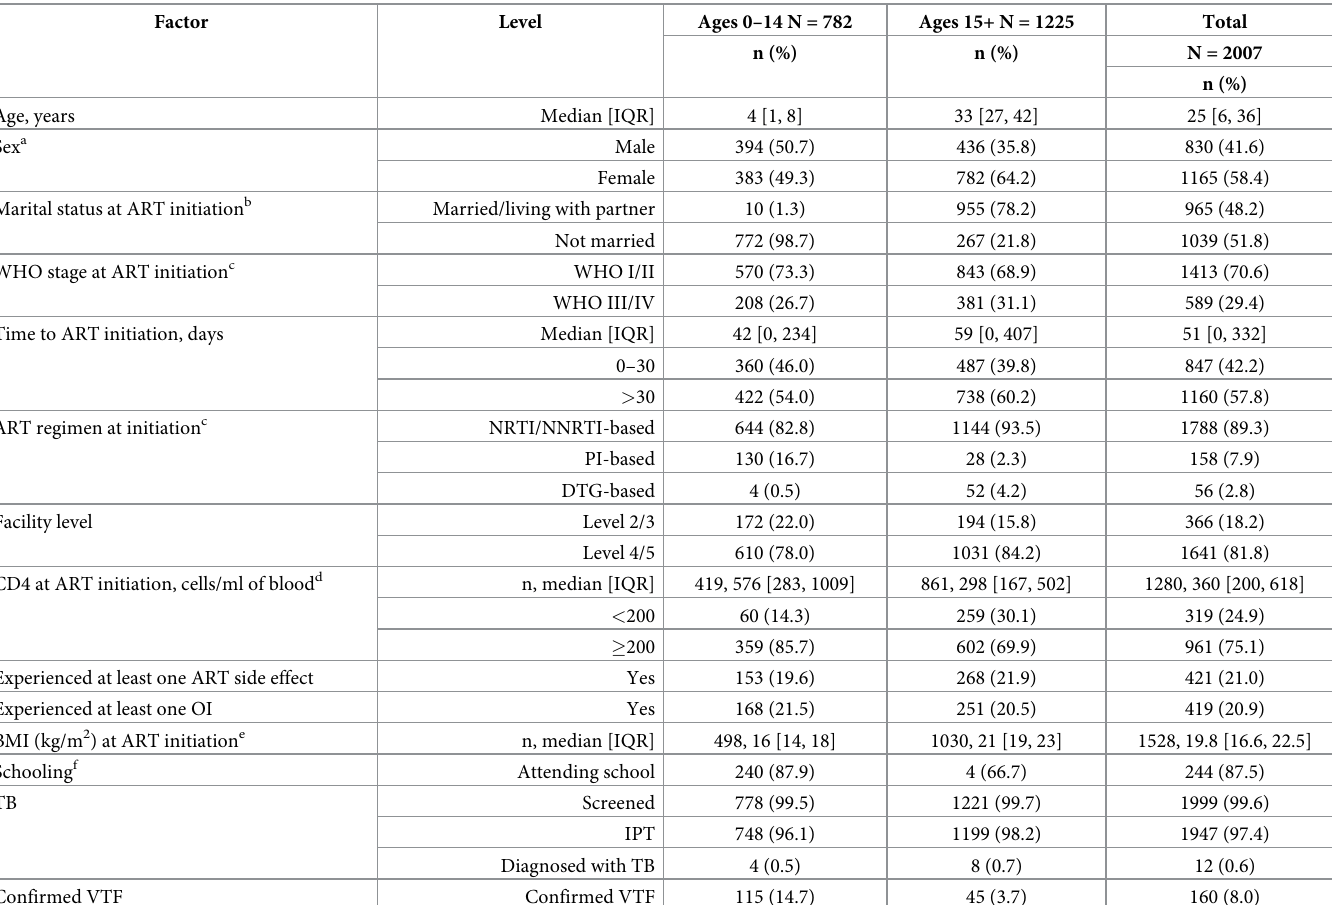
Table 1. Demographic and clinical characteristics of study participants by age